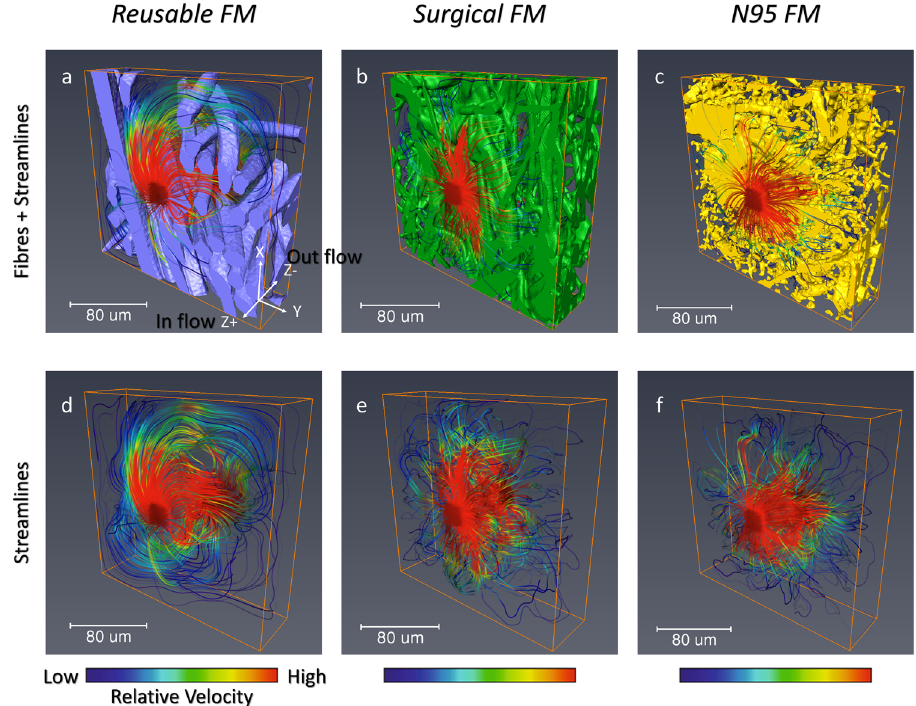
Fig. 4 Visualisation of the illuminated streamlines of the three face masks representing the velocity fi eld in the permeability simulation. The fi bre structures are superimposed with the fl ow streamlines a – c to visualise where and how the fl ow is blocked by the fi bres. The streamlines d – f are displayed to reveal the virtual ejected aerosol fl ow pathways, scaled according to their relative velocity.